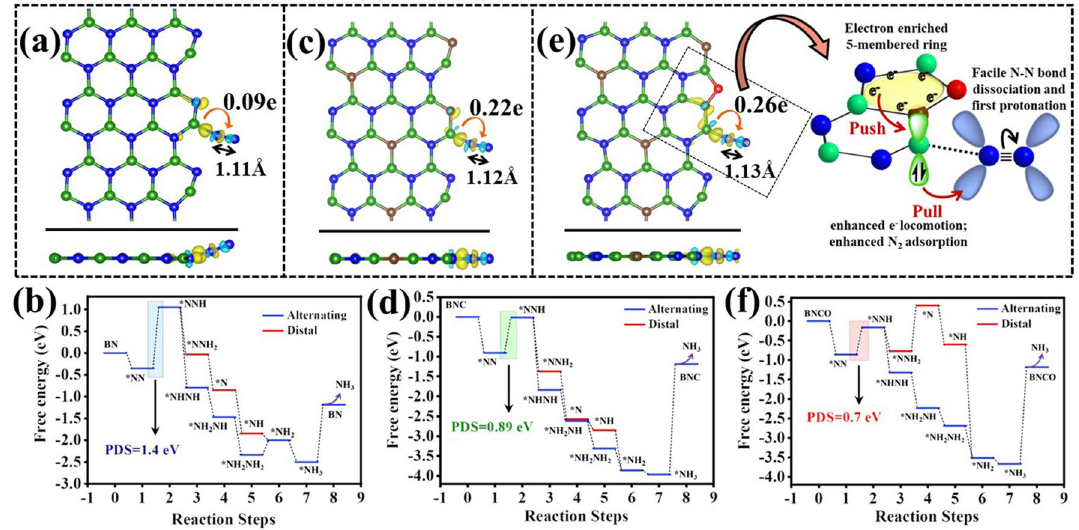
Fig. 6 Charge density difference analysis for a pristine BN, c BNC, and e BNCO systems. Yellow and blue lobes indicate electron accumula- tion and depletion, respectively (Iso-surface value = 0.001 e Å −3 ). The arrow and value indicate amount of Bader charge transferred. Free energy profile for NRR for b BN, d BNC, f